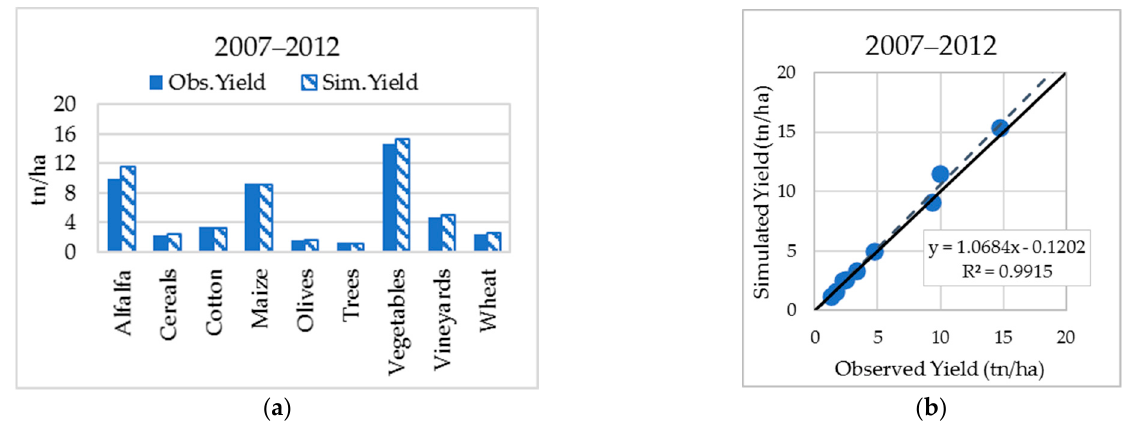
Figure 13. ( a ) Average simulated crop yield per crop type, and ( b ) spatially simulated crop yields against spatially observed crop yields for the calibration period 2007–2012.